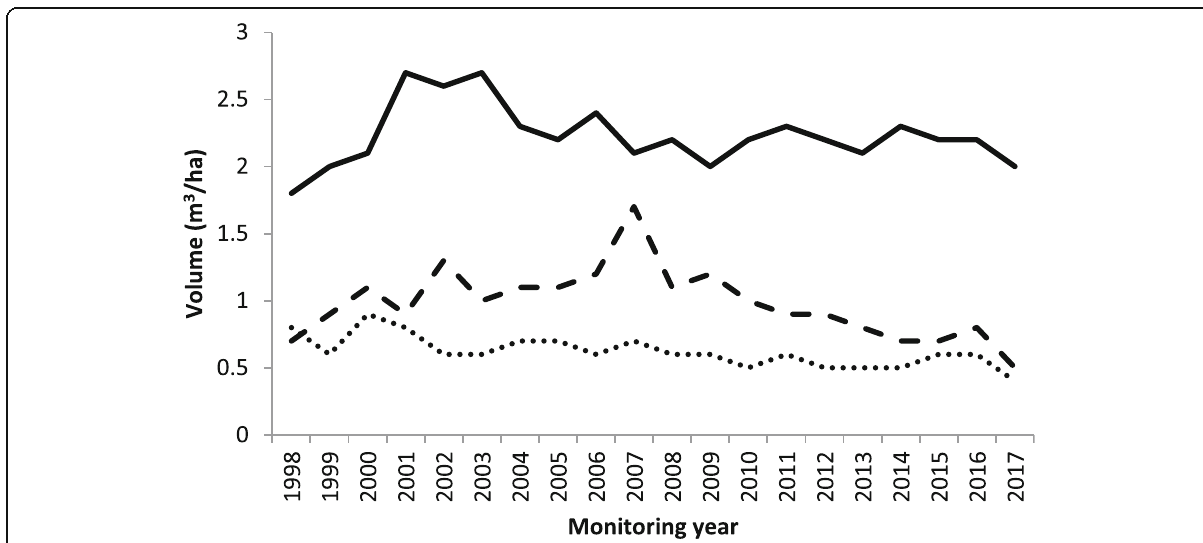
Fig. 3 Volumes of living large-diameter (DBH >20cm, solid line) and small-diameter (10 – 20cm, dotted lined) retention trees and dead trees (DBH > 10cm or DBH >20cm from 2005 onwards, dashed line) (m 3 /ha) in 1998 – 2017 in clearcutting areas of private forests (data: Forestry Centre Tapio 2013, Finnish Forest Centre 2019). The volume of living large-diameter retention trees has remained quite the same despite the starting peak in the early years of PEFC certification (early 2000s) (Kendall ’ s rank correlation coefficient r K = − 0.08, p = 0.643). The volume of living small-diameter retention trees has decreased during the monitoring years ( r K = − 0.61, p < 0.001) and that of dead retention trees has slightly decreased but not statistically significantly so ( r K = − 0.33, p = 0.053). The pooled volume of all living retention trees has decreased ( r K = − 0.35, p =